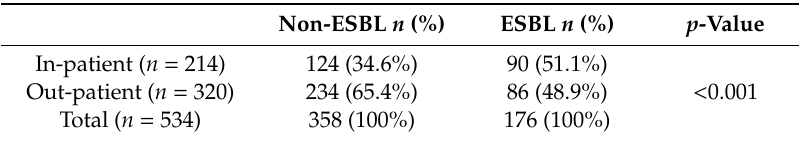
Table 3. Non-ESBL vs. ESBL producing organisms among in- and out-patients. A chi-squared test was used to evaluate any significant di ff erence between ESBL and non-ESBL groups for the hospital admission. The level of statistical significance was set at p <